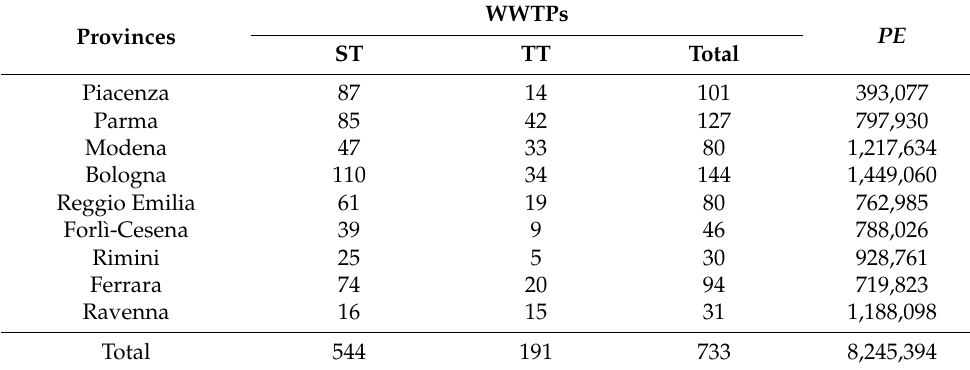
Table 2. WWTPs in operation in the Emilia-Romagna region as a function of treatment level. ST = sec- ondary treatment; TT = tertiary